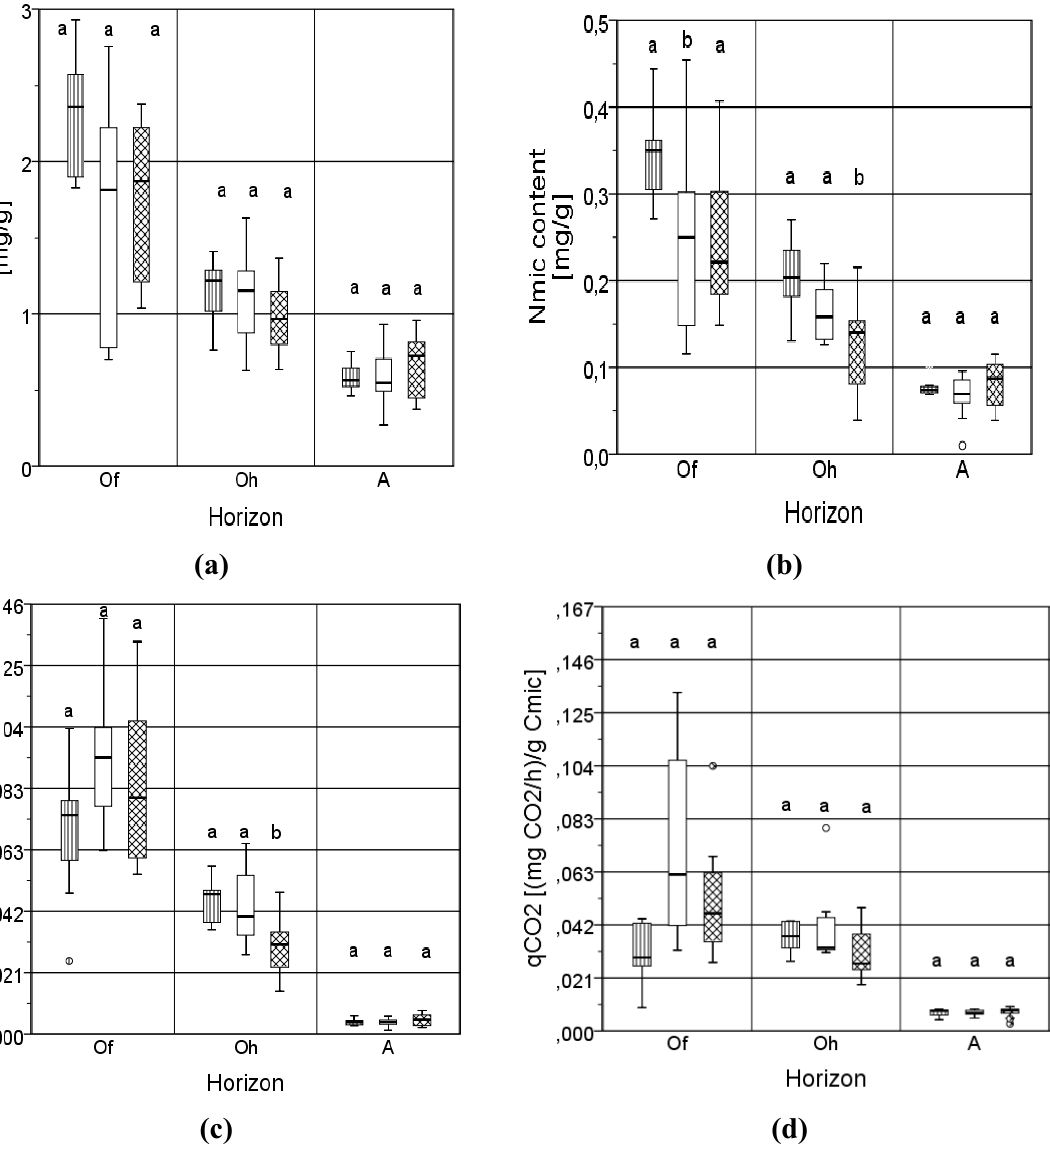
Figure 3. Box-whisker-plots of the tree strata (dashed: birch stratum, white: spruce-birch stratum, chequered: spruce stratum) in the three horizons depicting ( a ) microbial C content; ( b ) microbial N content; ( c ) basal respiration and ( d ) metabolic quotient (qCO 2 ). Different lower case letters indicate significant differences between strata within one horizon ( p <